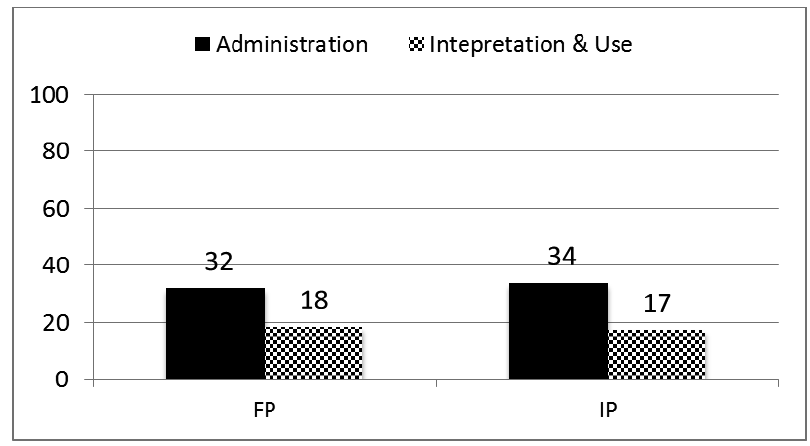
Figure 2: Training received in the implementation of ANAs